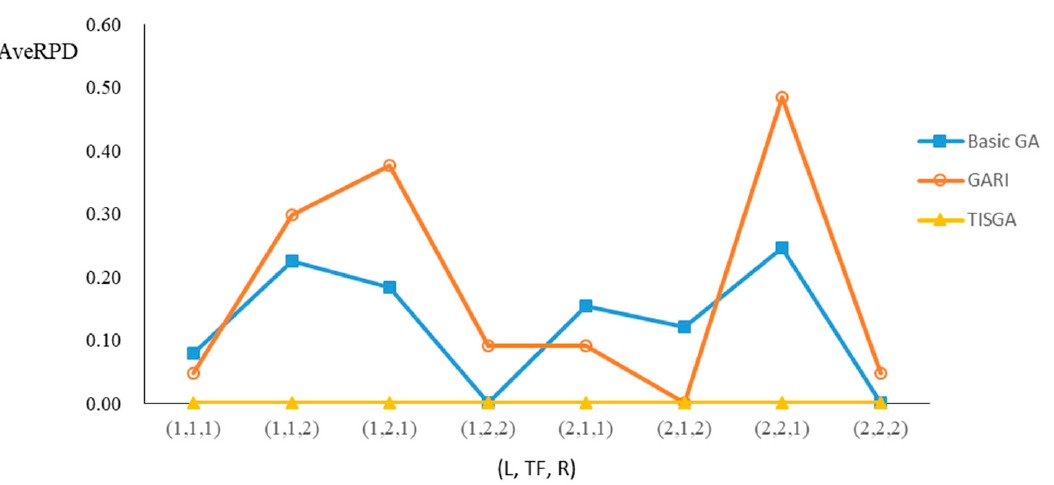
Figure 8. Comparison results for n = 20 with combinations of (L, TF, R).